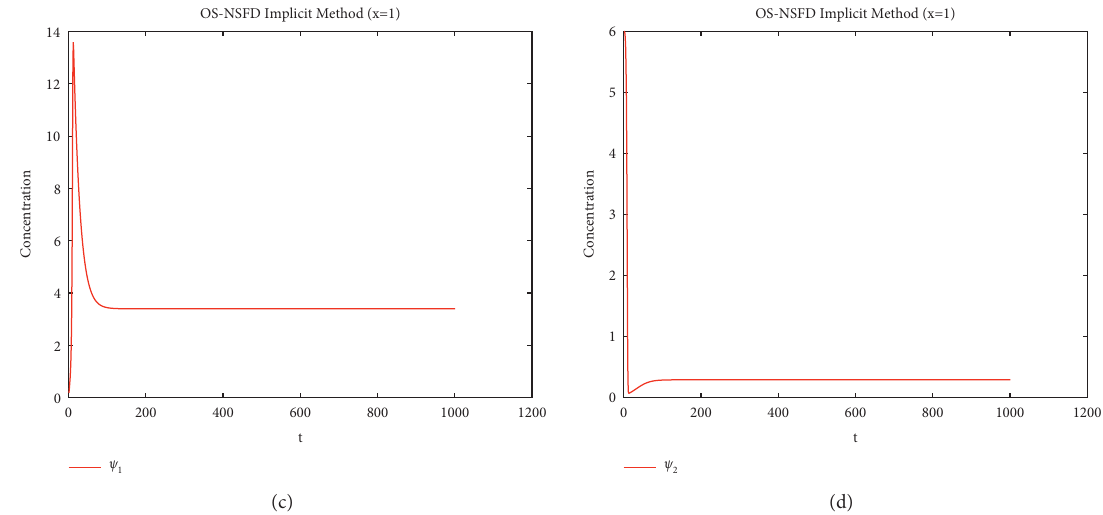
Figure 7: Mesh graphs and plot graphs of ψ � 1 , ϑ � 3 . 4 , λ � λ � 0 . 0006 , and ε κ � 0 . 1 , ϑ 1 2 1 2 graph of ψ . 2